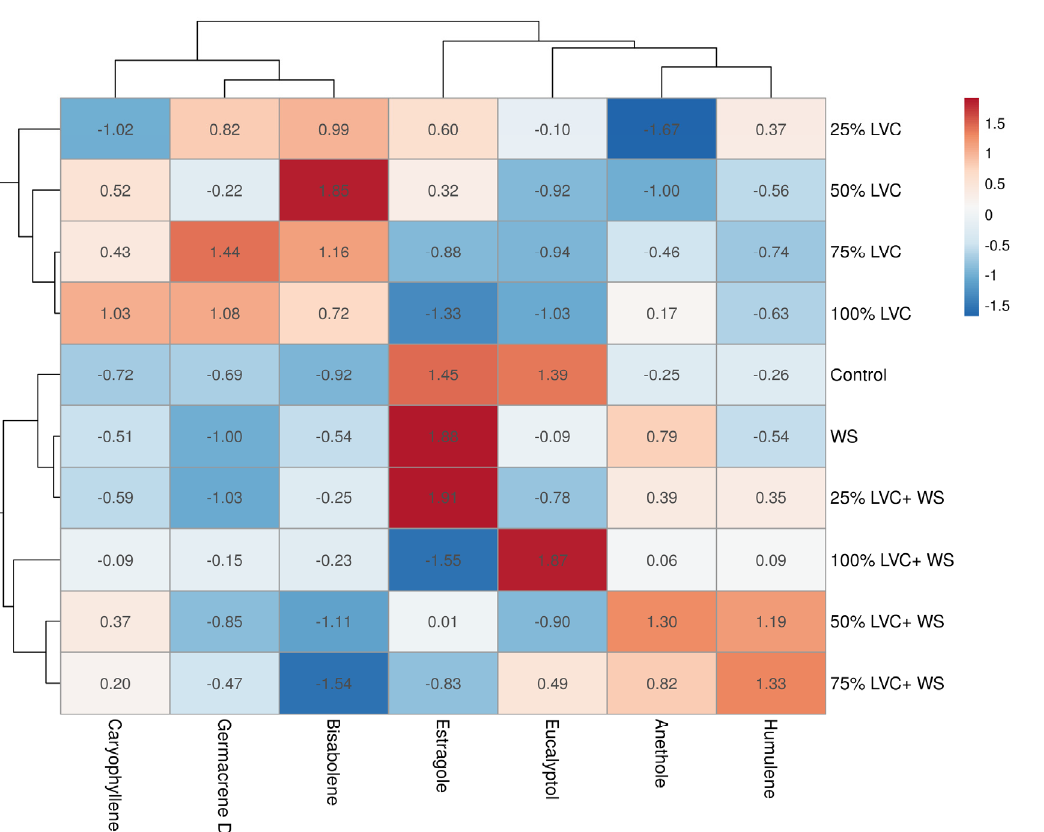
Figure 6. Correlation analysis of essential oil compounds corresponding to the treatments.